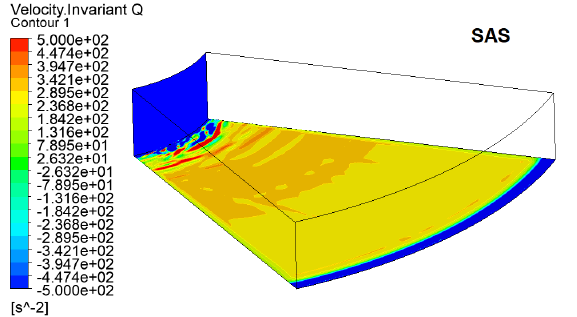
Fig. 6. Q-criterion: